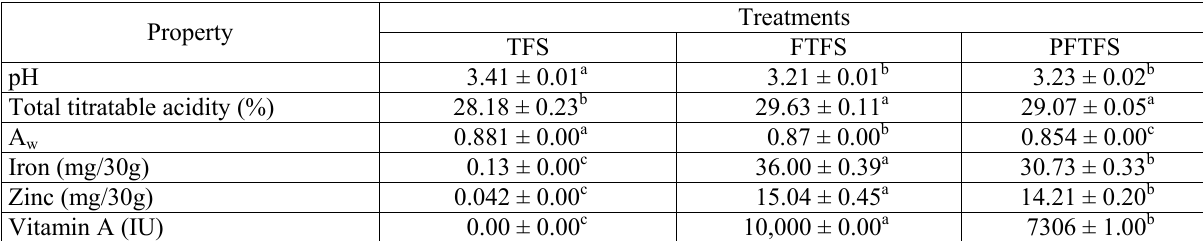
Table 6. Chemical qualities of fortified Vietnamese tamarind fish sauce before and after pasteurization Property